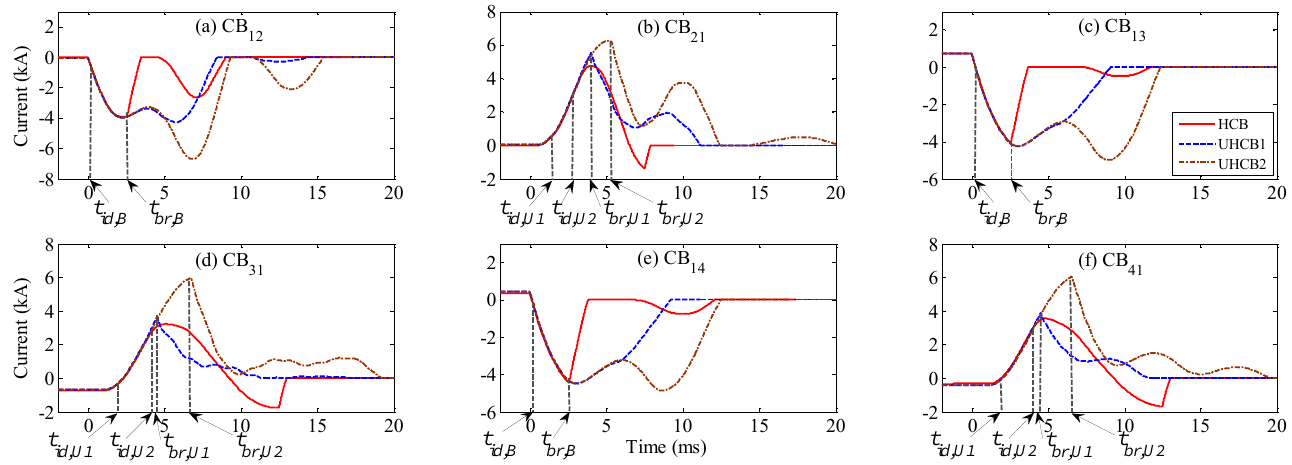
Fig. 8. Current in DCCB during fault at bus (B 1 ) for BCBs and UCBs (a) CB 12 , (b) CB 21 , (c) CB 13 , (d) CB 31 , (e) CB 14 , (f) CB 41